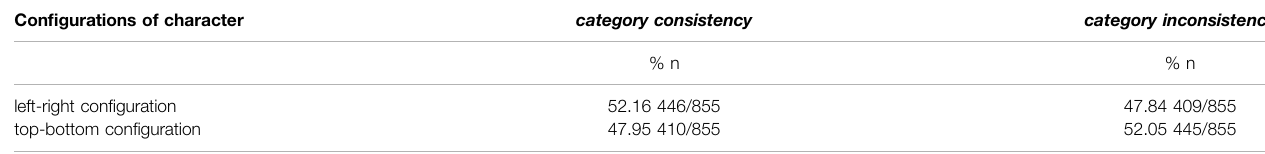
TABLE 1 | The percentage of all children ’ s choices for the category consistency of semantic radical. Con fi gurations of character